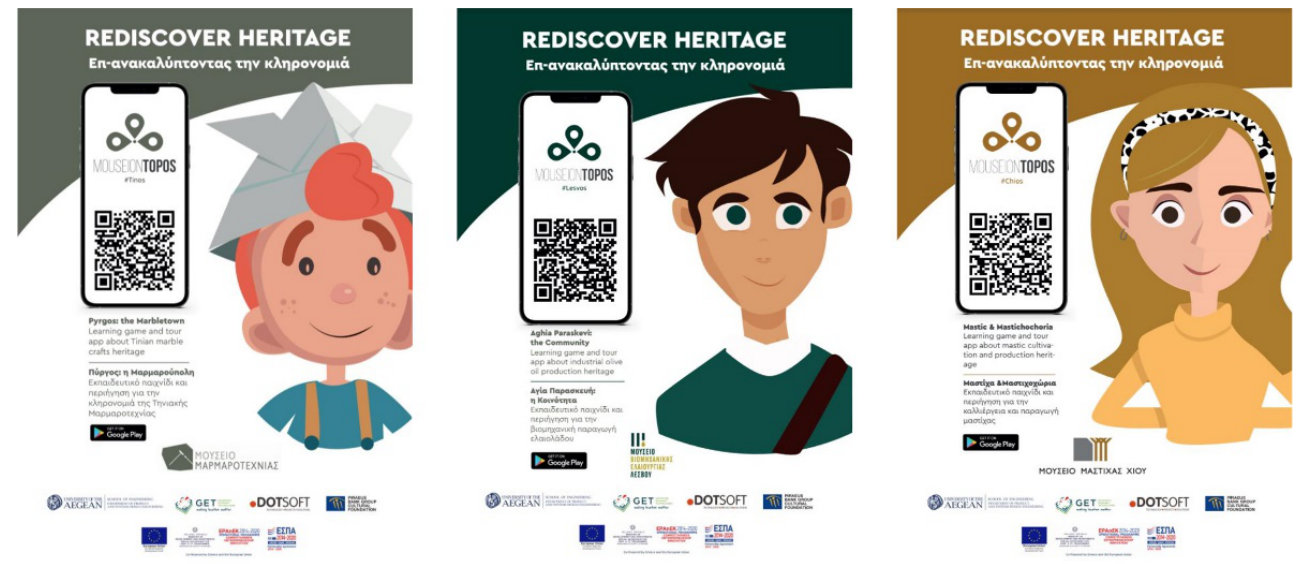
Figure 9. Posters in the museums and settlements that inform visitors about the mobile games.